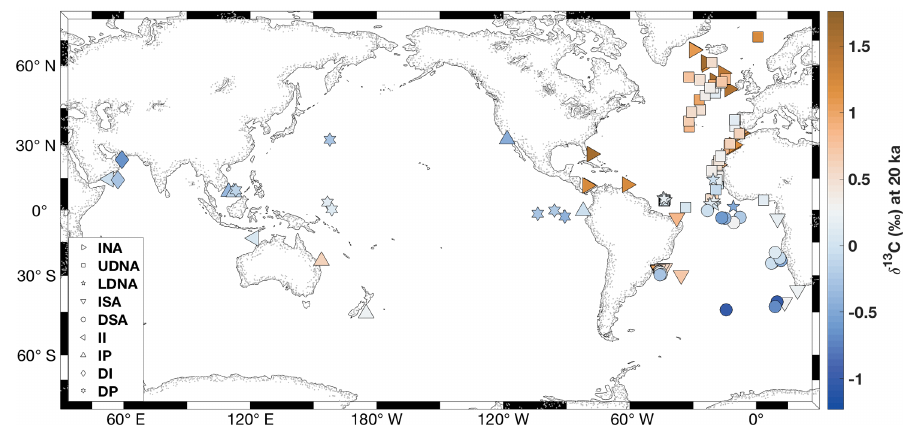
Figure 1. Locations of 127 core sites compiled for this study, color coded by LGM δ 13 C estimates at each core site. Markers indicate locations of cores in the nine regions: INA is the intermediate North Atlantic; UDNA is the upper deep North Atlantic; LDNA is the lower deep North Atlantic; ISA is the intermediate South Atlantic; DSA is the deep South Atlantic; II is the intermediate Indian; DI is the deep Indian; IP is the intermediate Pacific; DP is the deep